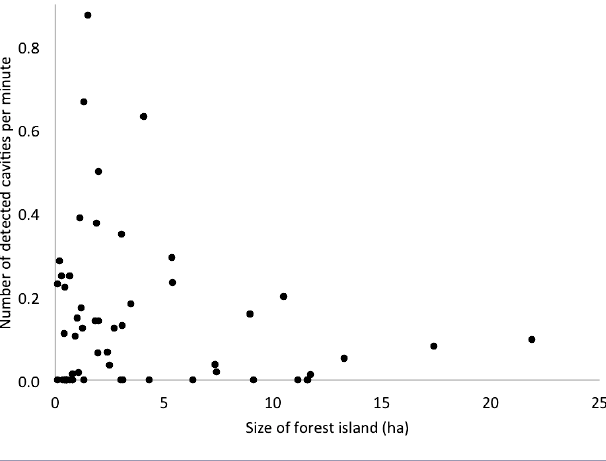
Fig. 1 . Number of detected cavities per time and size of surveyed forest islands in northern